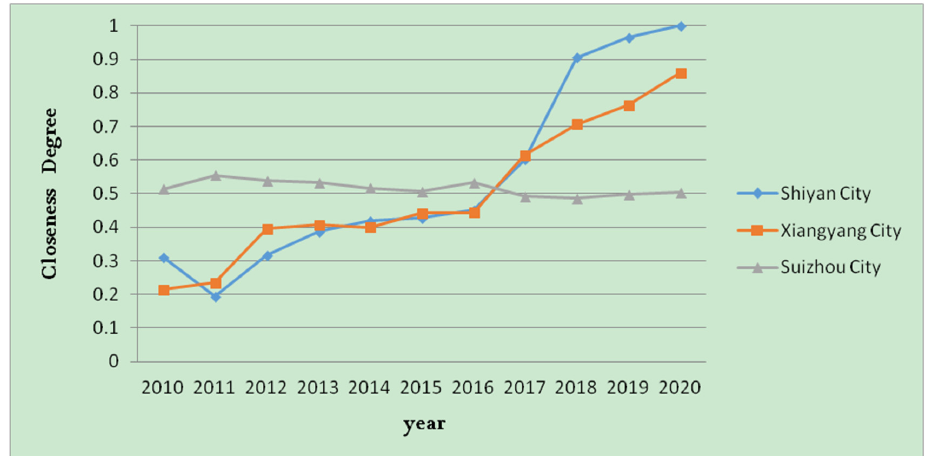
Figure 2. The closeness degree of the ecological benefits of cultivated land use in three study areas during 2010–2020.